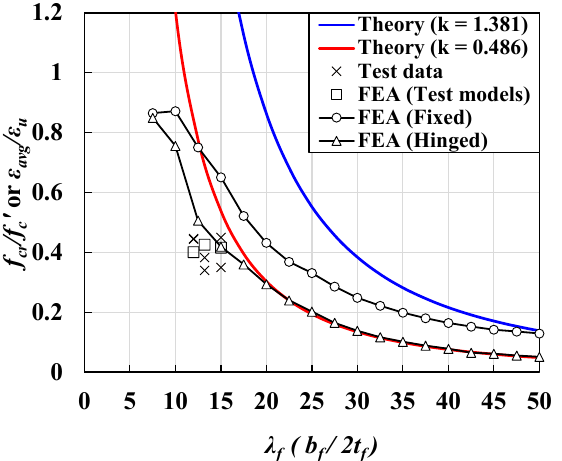
Figure 18. Comparisons between presented FEA results and test data in the literature (test data from reference [23]).